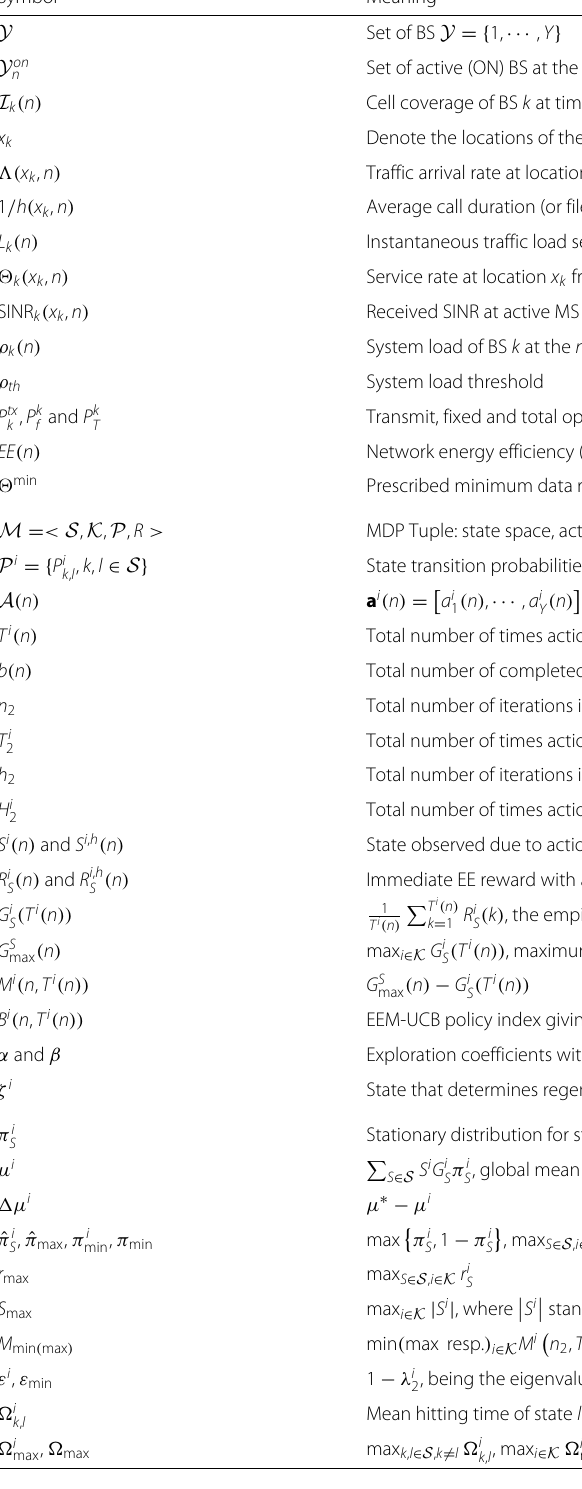
Table 1 List of the main symbols in the paper Symbol Meaning